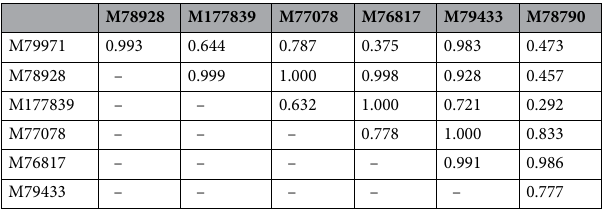
Table 5. Pair-loci D’ linkage disequilibrium